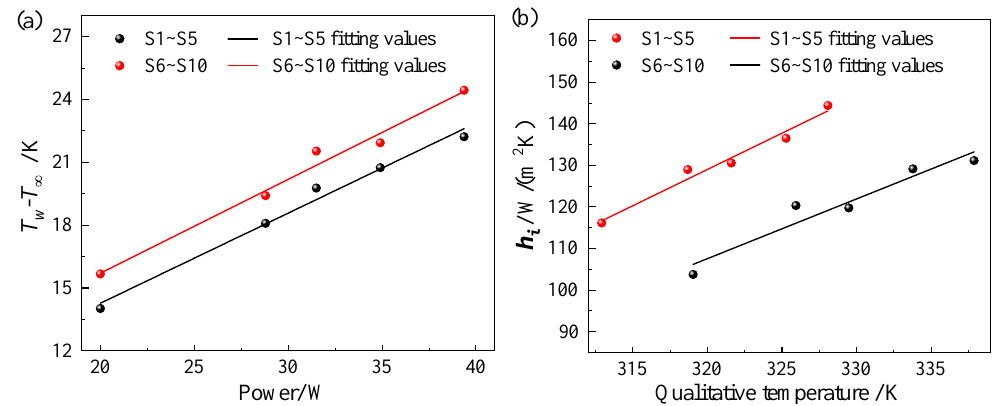
Figure 7. ∆ T and h i obtained by steady-state round-tube experiment: ( a ) ∆ T under different powers; ( b ) h i under different qualitative temperatures.